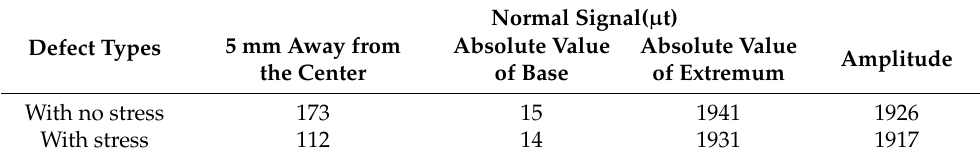
Table 2. Characteristic strength of normal signal.